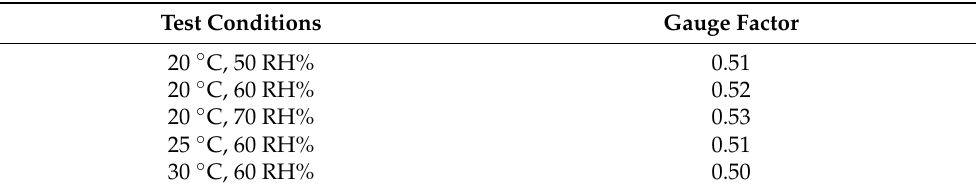
Table 3. Sensor strain sensitivity (GF) over 0% to 40% elongation, measured at different temperature and relative humidity (RH), and recorded at 0.5 Hz strain rate.